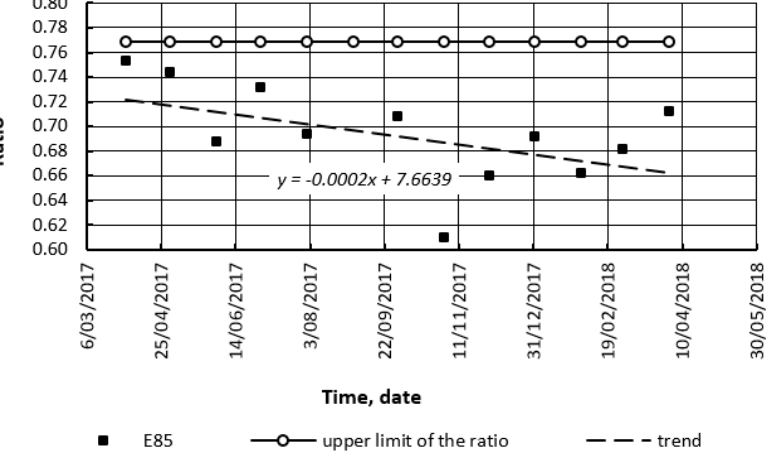
Figure 13. E85 / gasoline prices ratio in the USA [49].